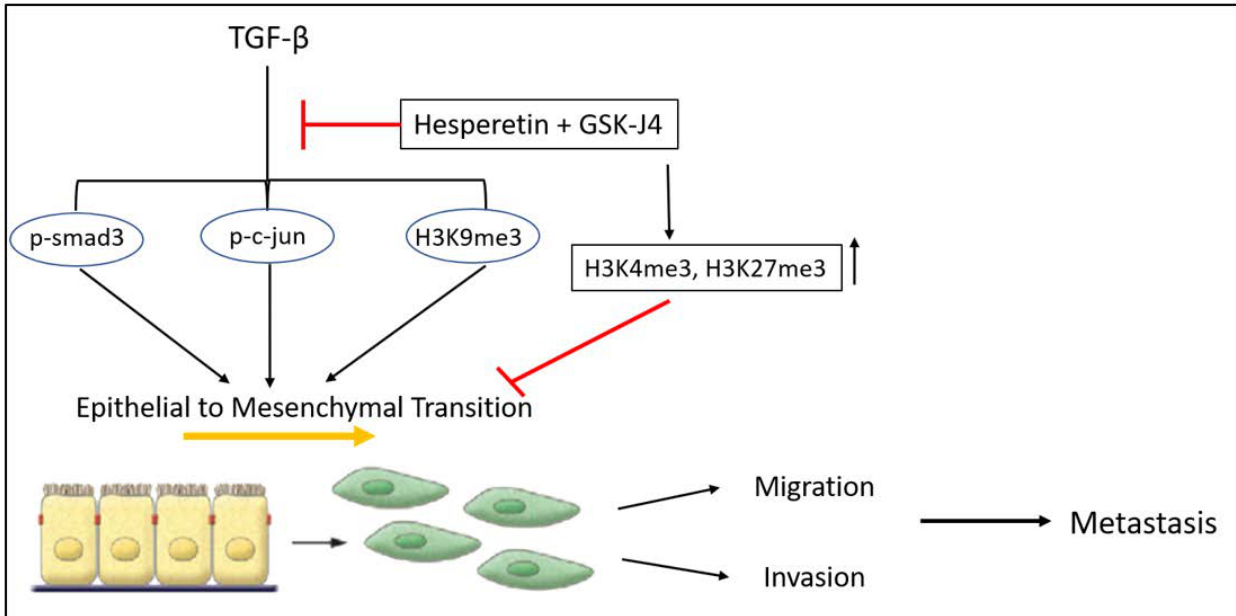
Figure 5. A schematic summary of the effects of combinatorial treatment of hesperetin and GSK-J4 on TGF β -induced EMT and histone methylations in prostate cancer